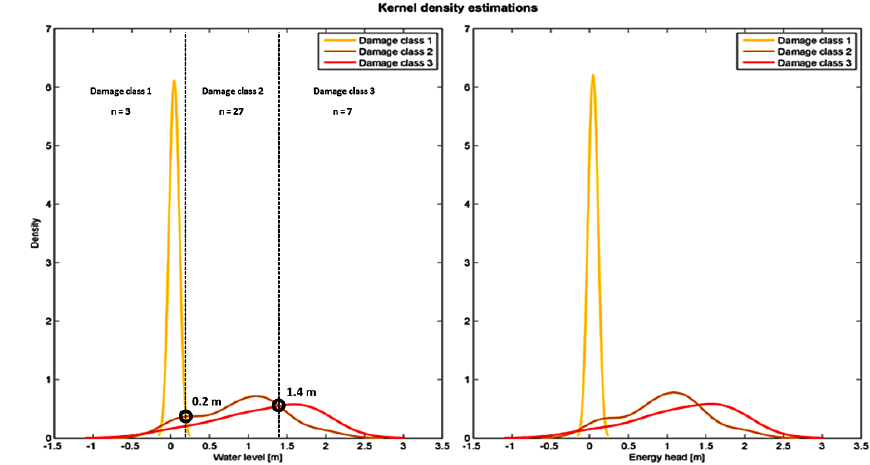
Figure 4. Kernel density plots for the impact parameters h and E . The parameter values at the marked graph intersection points determine the thresholds in the damage model to assign the most likely damage class to each track section. The derived values apply equally to both